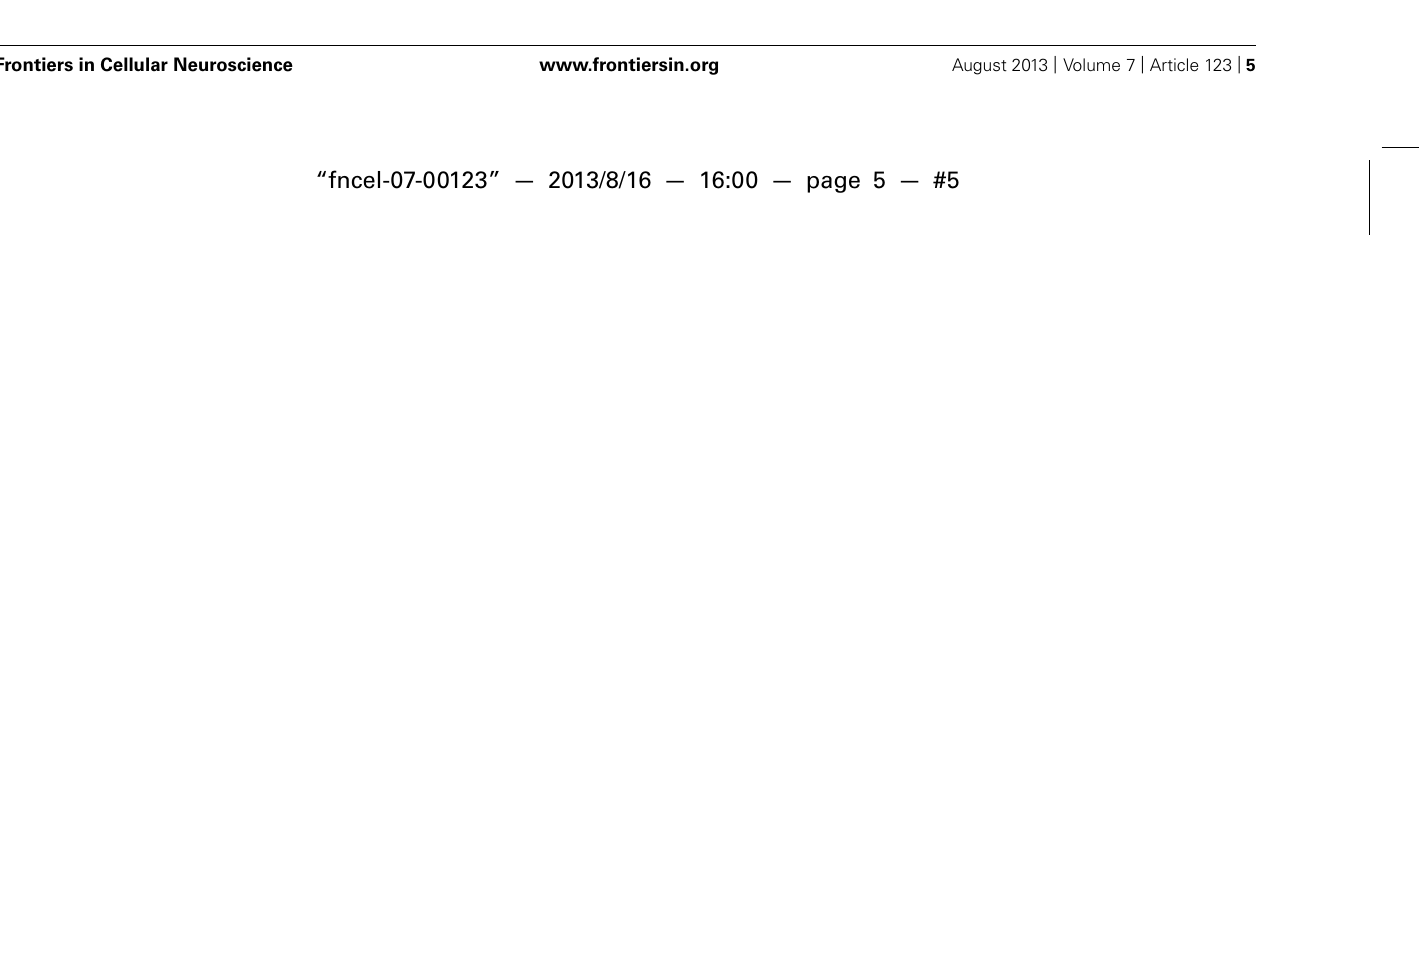
the area of the GCL as measured by MCID. Density of newly born neural cells in the SGZ was determined by dividing the number of BrdU-labeled cells co-labeled with NeuN, by the length of the SGZasmeasuredbyMCID.Countsof cellsintheGCLwereunique and non-inclusive of the cells seen in the SGZ.Additionally, counts were obtained for the hilus, defined as the area between the two blades of the granule cell layer, excluding cells in the SGZ. Per- centages for co-labeling for GCL and SGZ were determined by the following formula: [(BrdU + NeuN + cell density)/(BrdU + cell density)] ×